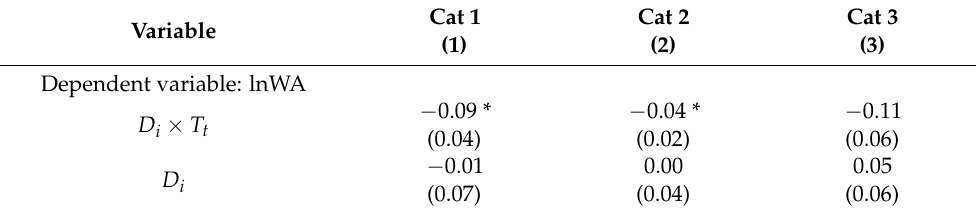
Table 5. Estimation results of the DID models for different wheat-sown area